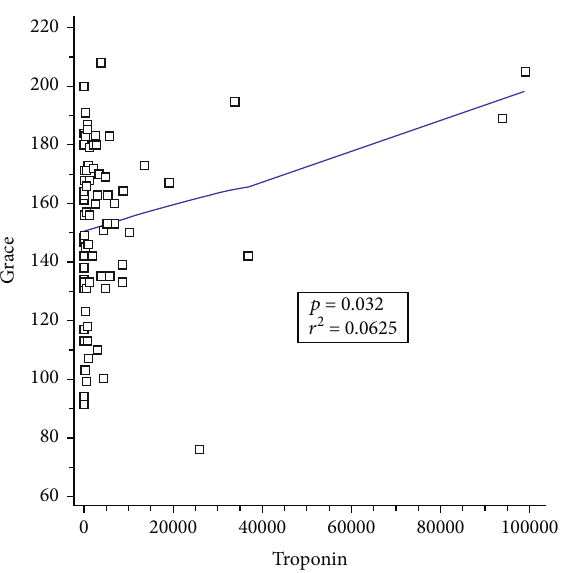
Figure 4: Correlation between the troponin I level and the Global Registry of Acute Coronary Events (GRACE) score in patients with